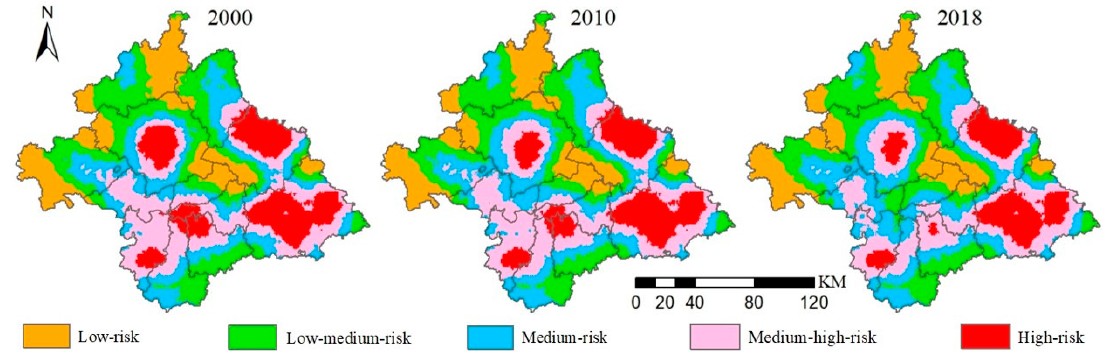
Figure 7. Spatial distribution of ecological risk levels in Nanning.